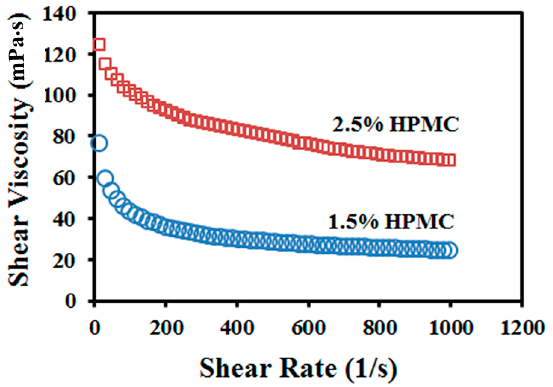
Figure 1. Suspension shear viscosity vs. shear rate.